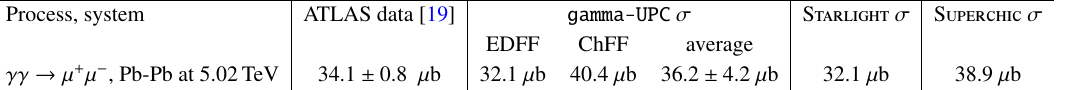
Table 13 . Fiducial exclusive dimuon cross sections measured in Pb-Pb UPCs at p (cid:22) > 4 GeV, j (cid:17) (cid:22) j < 2 : 4, m (cid:22) + (cid:22) (cid:0) > 10 GeV, p T ;(cid:22) + (cid:22) (cid:0) < 2 GeV), compared to the theoretical gamma-UPC results T obtained with EDFF and ChFF (cid:13) fluxes (and their average), as well as with the S tarlight and S uperchic MC